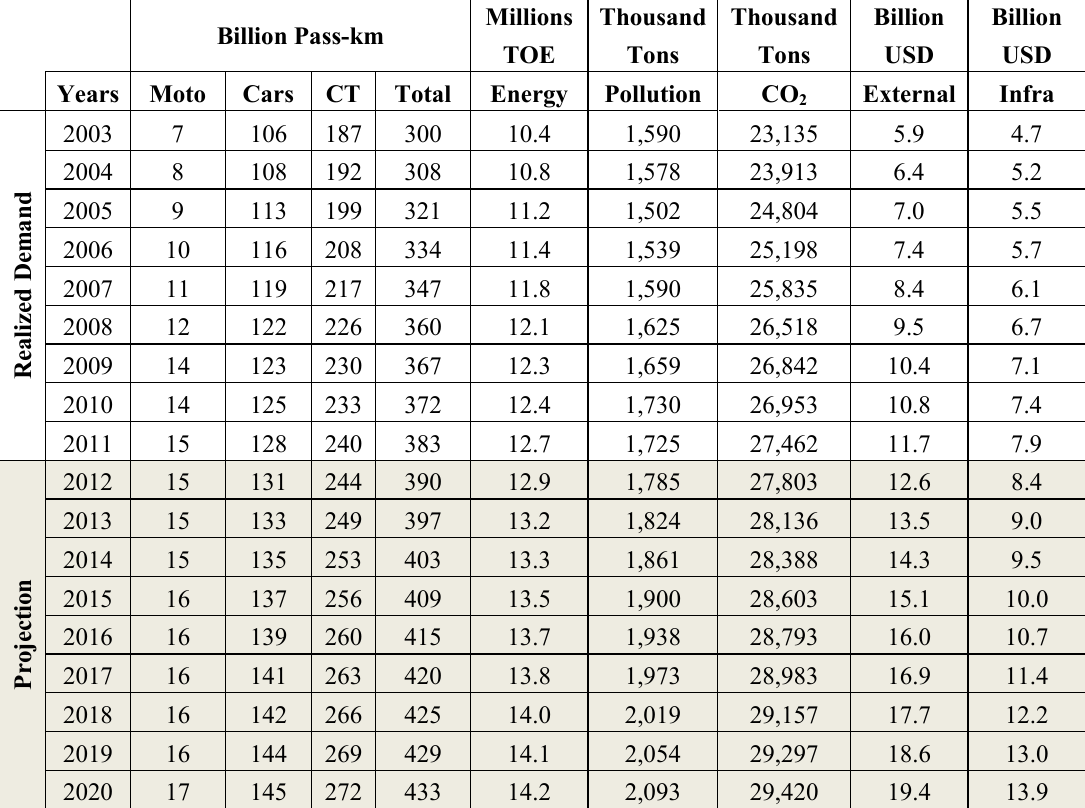
Table A6. Projection of external costs up to